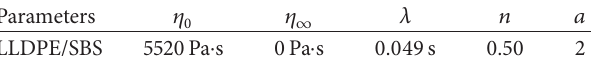
Table 1: Geometrical configurations of the tri-screw extruder. Parameters Symbols